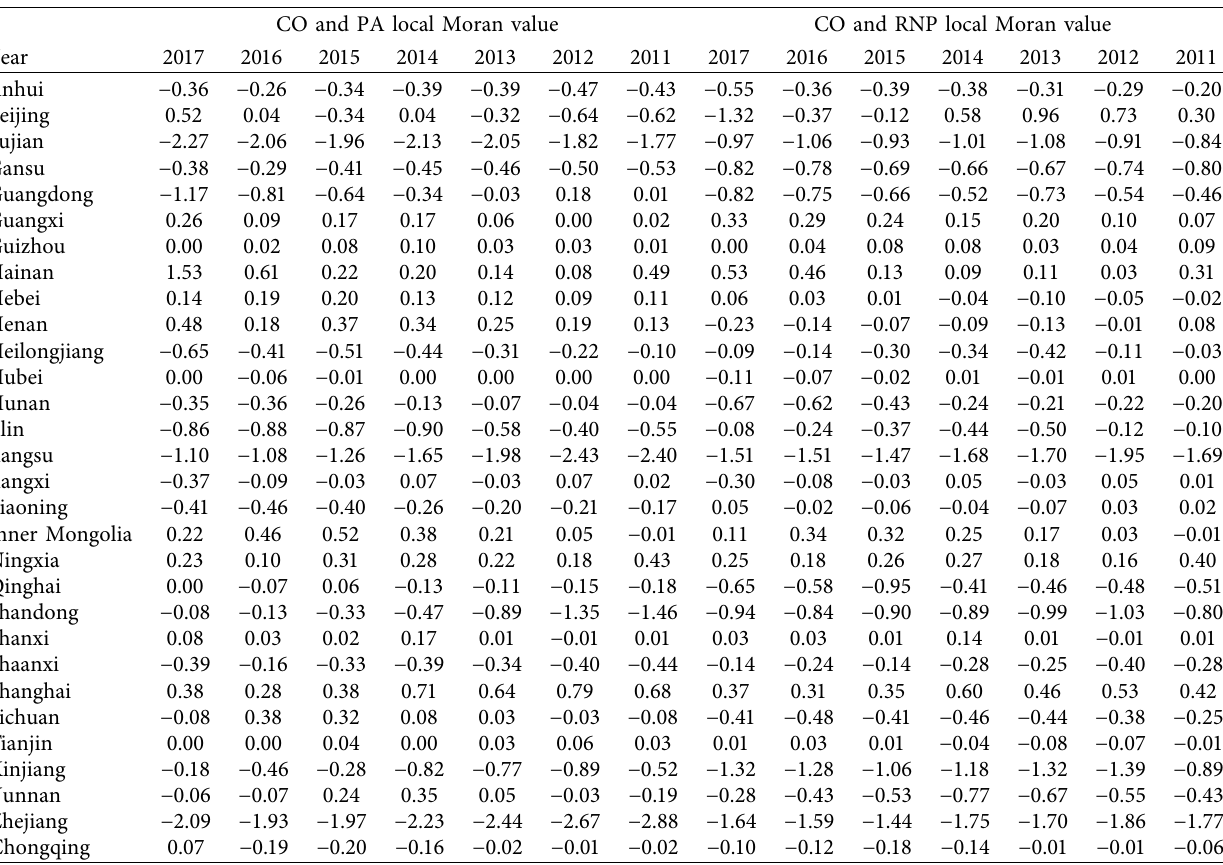
Table 6: Results of bivariate local Moran